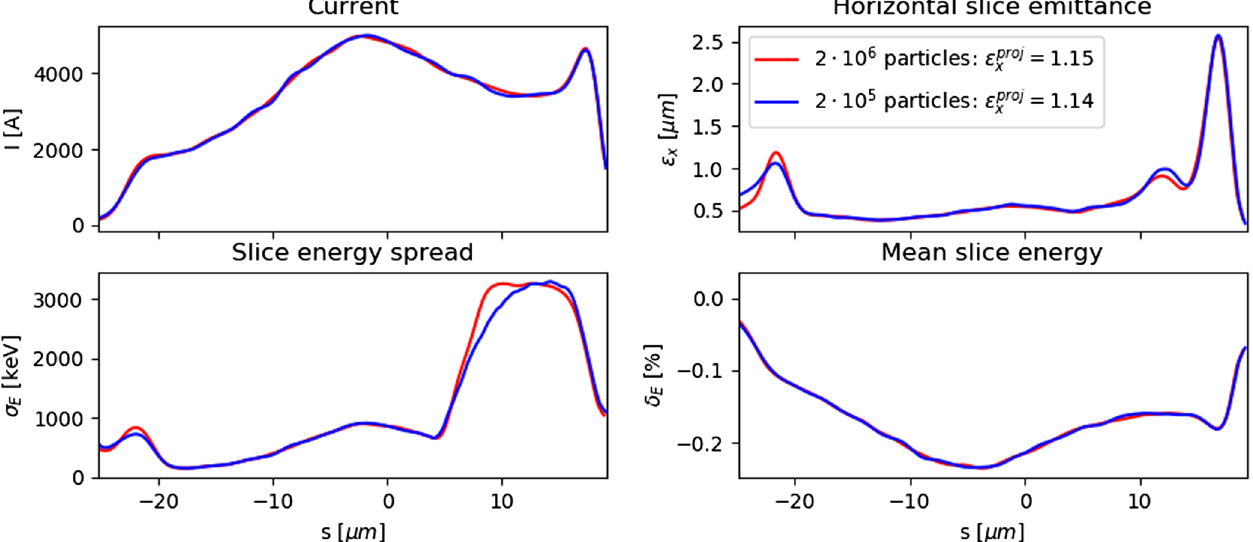
FIG. 14. Comparison of the slice parameters calculated with 2 × 10 5 (in blue) and 2 × 10 6 (in red) macroparticles.